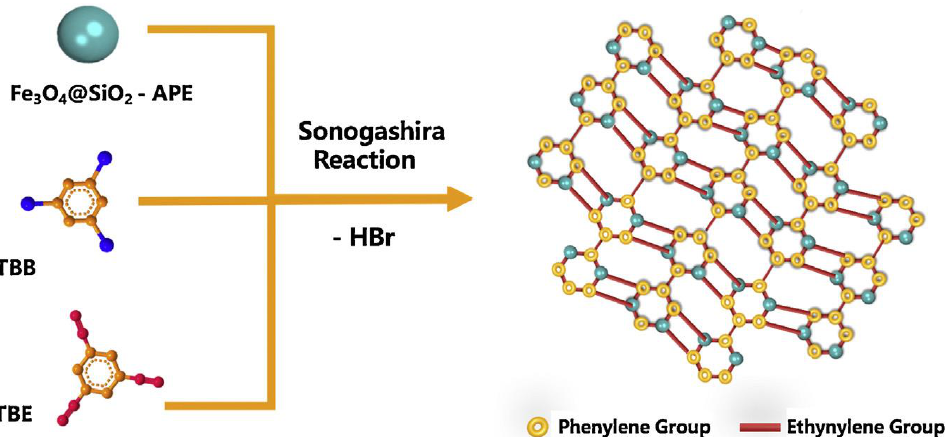
Figure 3. Synthesis of magnetic conjugated microporous polymer with conjugated three-dimensional network structure. Reprinted from [49] with permission from Elsevier, 2020.